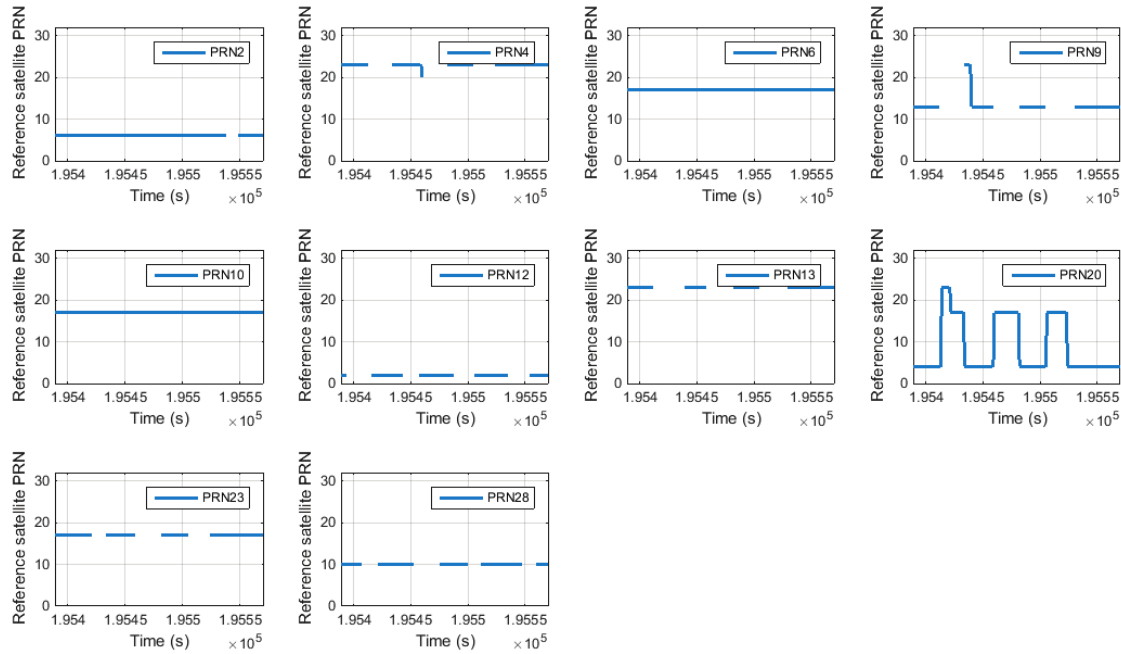
Figure 15. Proposed reference satellite PRN for each satellite.